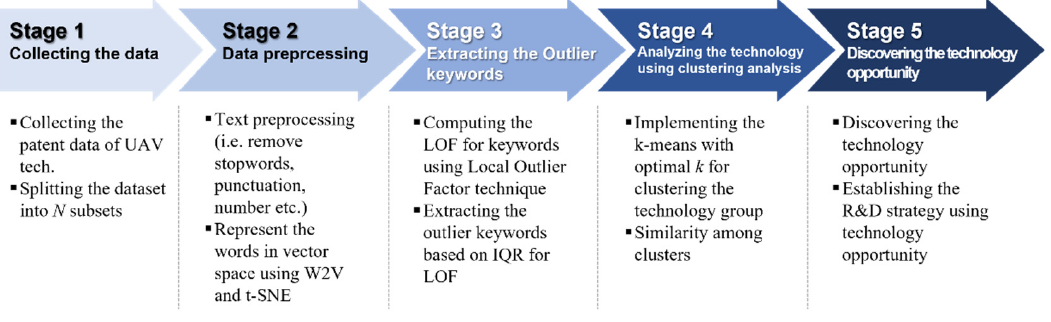
Figure 4. Proposed methodology process.